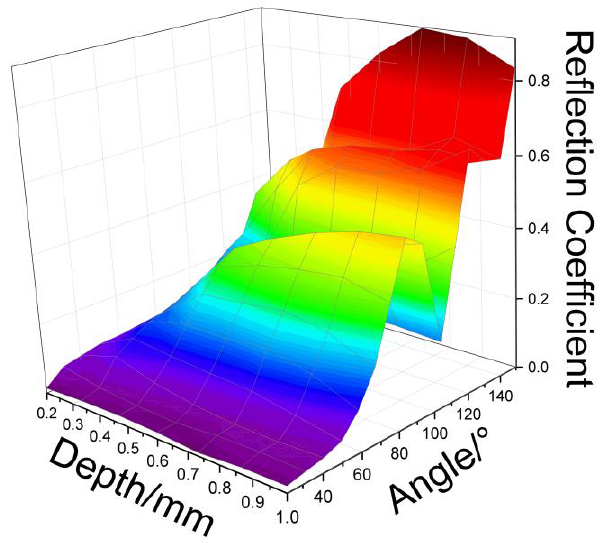
Figure 10. 3D map of the angle – depth – reflection coefficient.